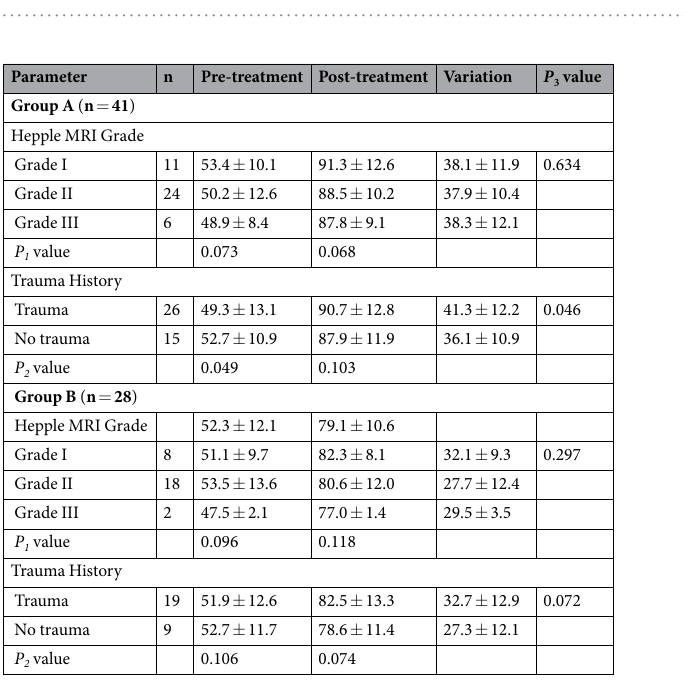
Figure 1. Progression of AOFAS scores in peri-treatment between the two groups.